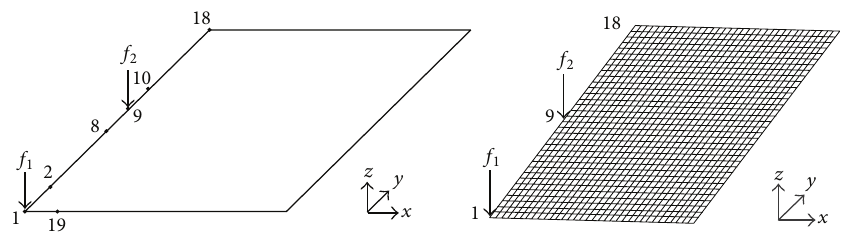
Figure 12: The location of 𝑓 1 and 𝑓 2 in the Mindlin